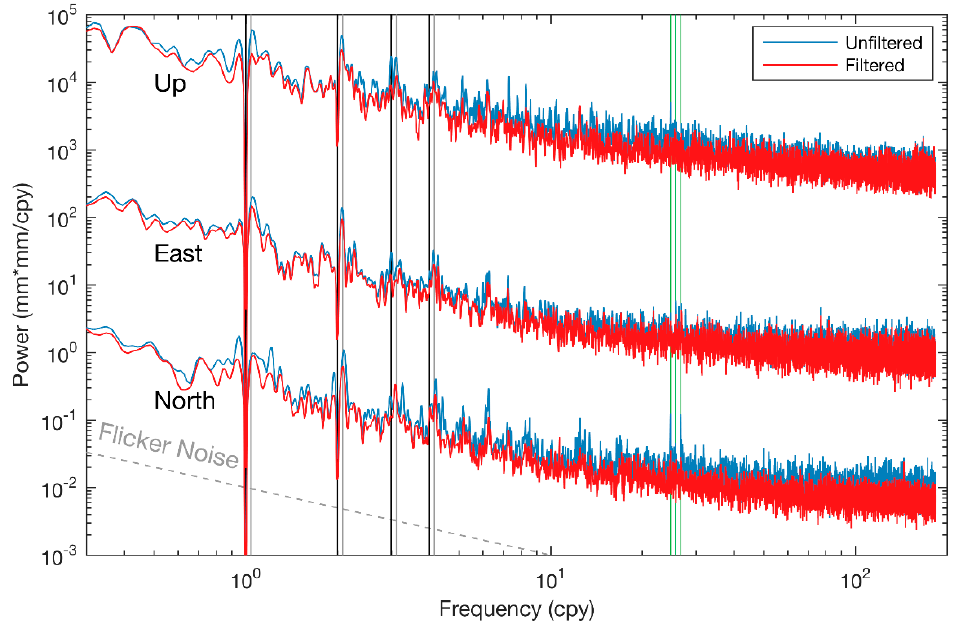
Figure 7. Stacked power spectra of the unfiltered (blue) and filtered (red) CMONOC-I residual time series with annual and semi-annual signals removed. The stacked power spectra for the up and east components have been shifted upward for clarity (by factors of 5000 and 100, respectively). Vertical black and gray lines indicate the annual (1 cpy) and draconitic (1.04 cpy) oscillations and their harmonics up to the 4th. Vertical green lines indicate the frequencies of 24.75, 25.74, and 26.74 cpy.